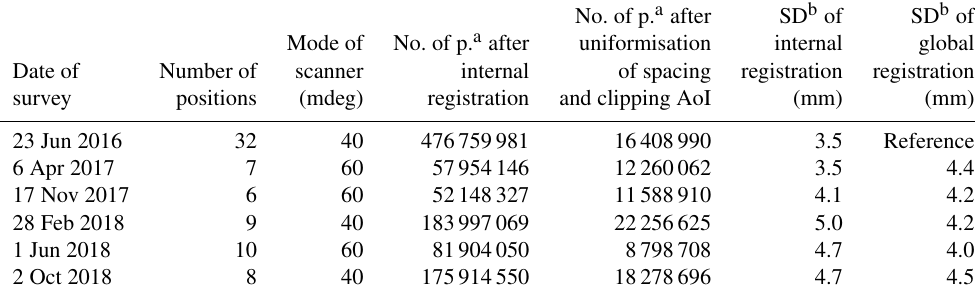
Table 1. Characteristics of the time series database. No. of p. a after SD b of SD b of Mode of No. of p. a after uniformisation internal global Date of Number of scanner internal of spacing registration registration survey positions (mdeg) registration and clipping AoI (mm) (mm) 23 Jun 2016 32 40 476759981 16408990